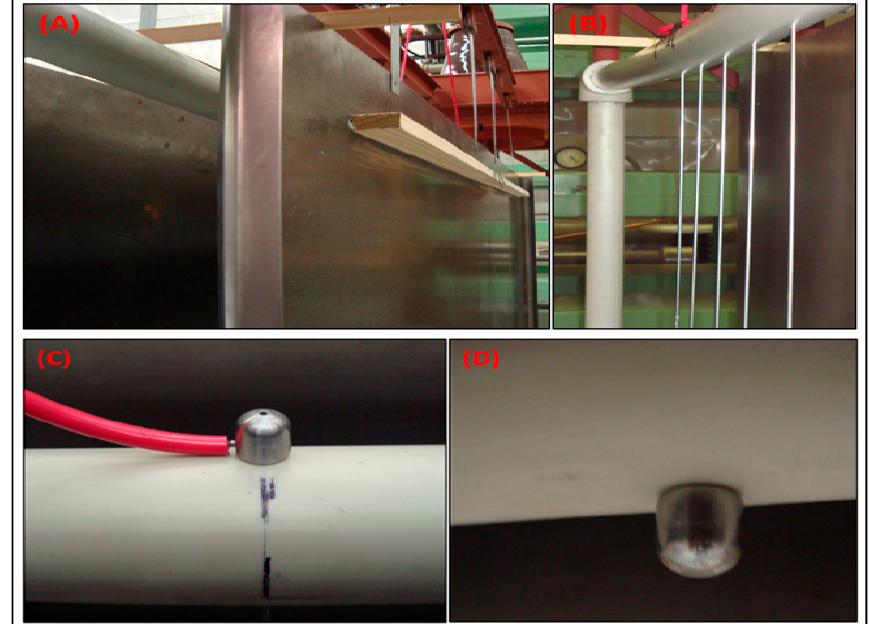
Figure 12. Collecting plates’ configuration of WDESP at the Laboratory of High Voltage Engineering at Czech Technical University in Prague, Czech Republic: ( A ) collecting plates with a curved edge, ( B ) discharge wires, ( C ) top-ended sphere, and ( D ) bottom-ended sphere.